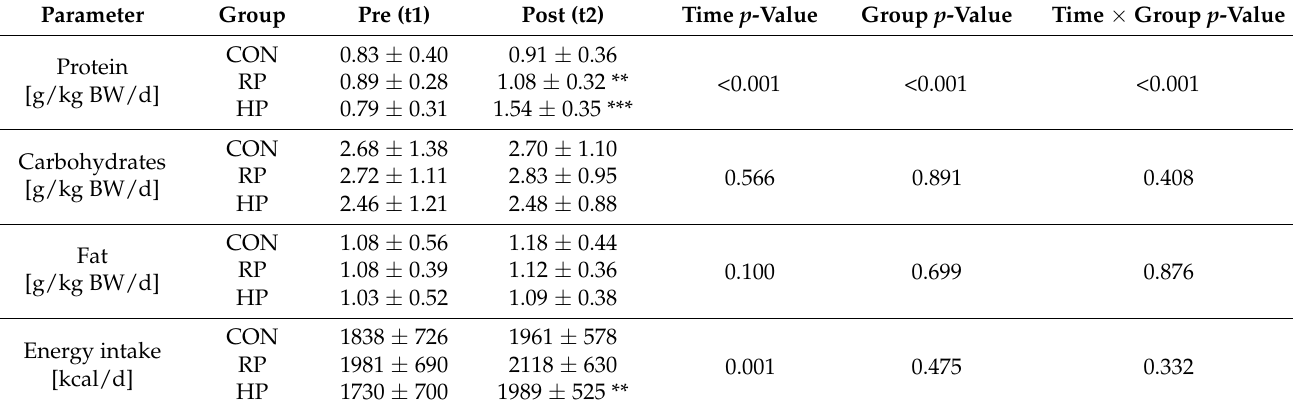
Table 3. Intervention effects on macronutrient and energy intake in the Austrian study ( n =